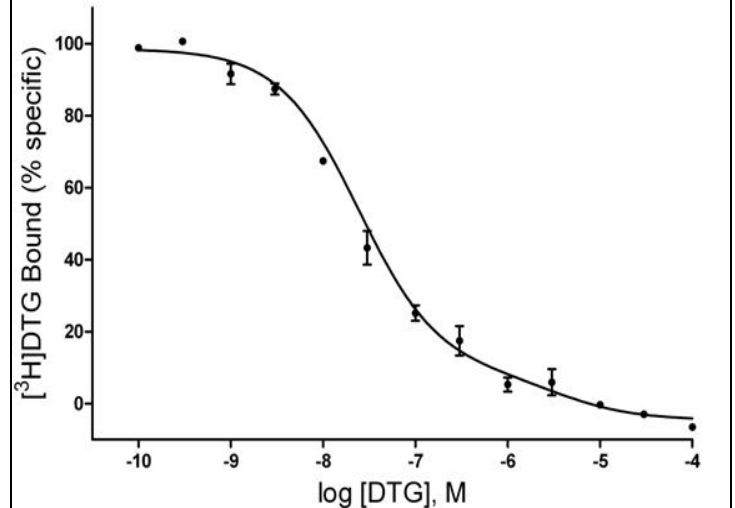
Figure 2. Homologous competition of radiotracer and nonradioactive DTG at guinea pig